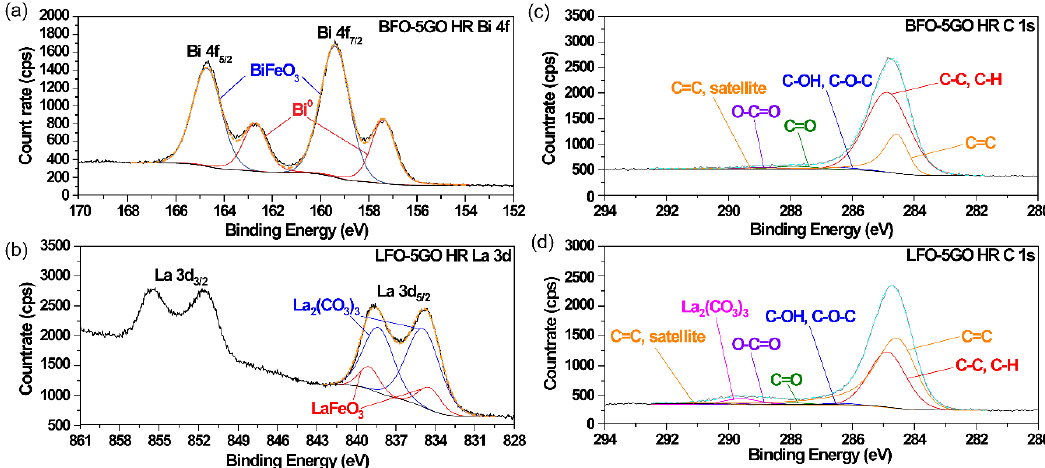
Figure 6. High-resolution ( a ) Bi 4f spectrum of GO/BFO and ( b ) La 3d spectrum of GO/LFO nanofiber films, and high-resolution C 1s spectra of ( c ) GO/BFO and ( d ) GO/LFO nanofiber films. The GO concentration of these samples was 5%.